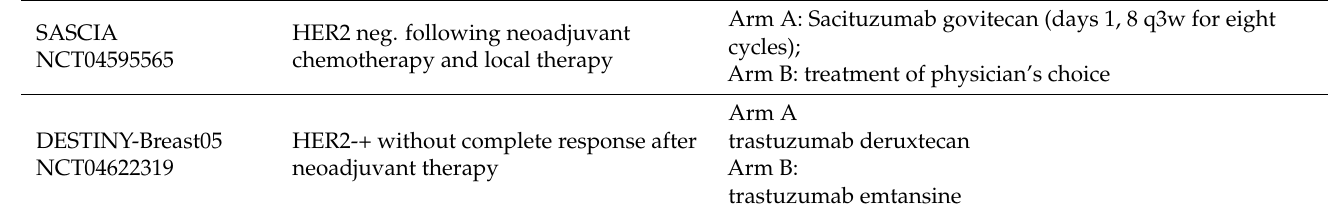
Table 2. Ongoing